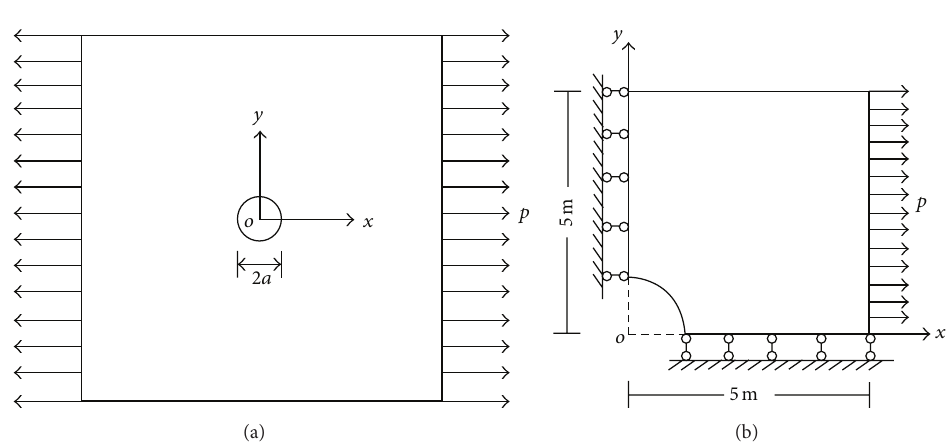
Figure 11: Plate with a central circular hole and its model problem: (a) a plate with a hole, (b) a quarter of the plate and boundary conditions.